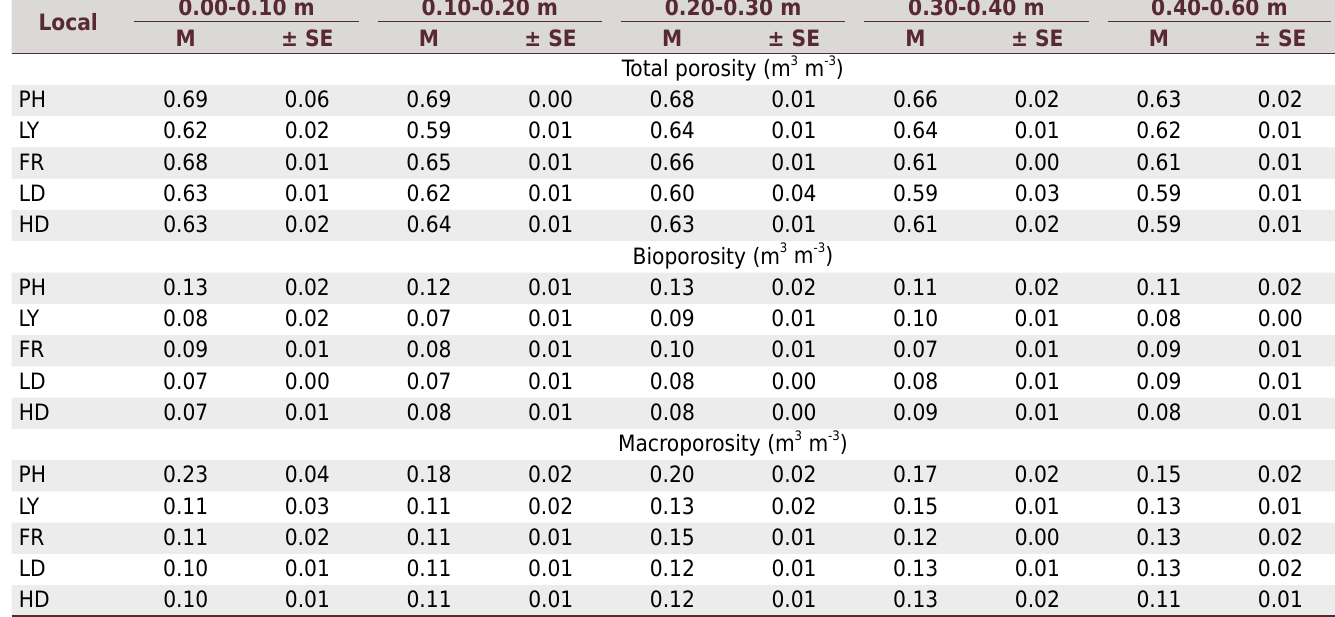
Table 2. Soil physical properties in different layers of the Dystric Cambisol (Humic) evaluated at pre-harvest (PH), and post-harvest in the areas of log yards (LY), forest residues (FR), low disturbance (LD) and high disturbance (HD), in a Pinus taeda reforestation, with the means (M) and standard error range